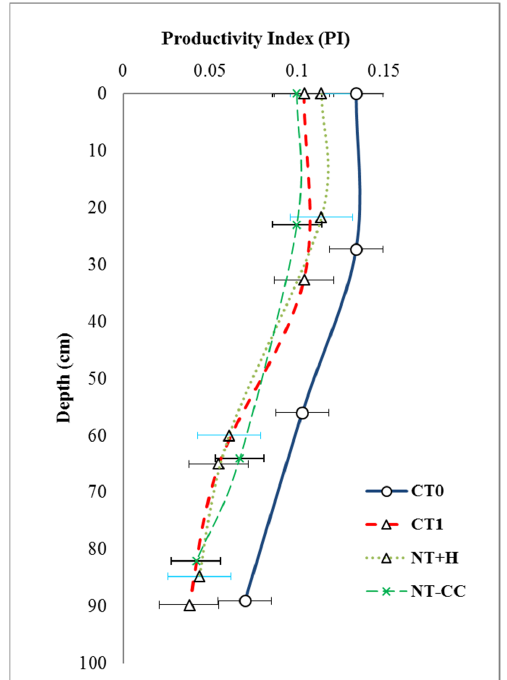
Figure 4. Variation in PI in soil profiles under different management systems. Conventional tillage (CT0; CT1), no tillage with herbicide (NT + H), and no tillage with cover (NT-CC).